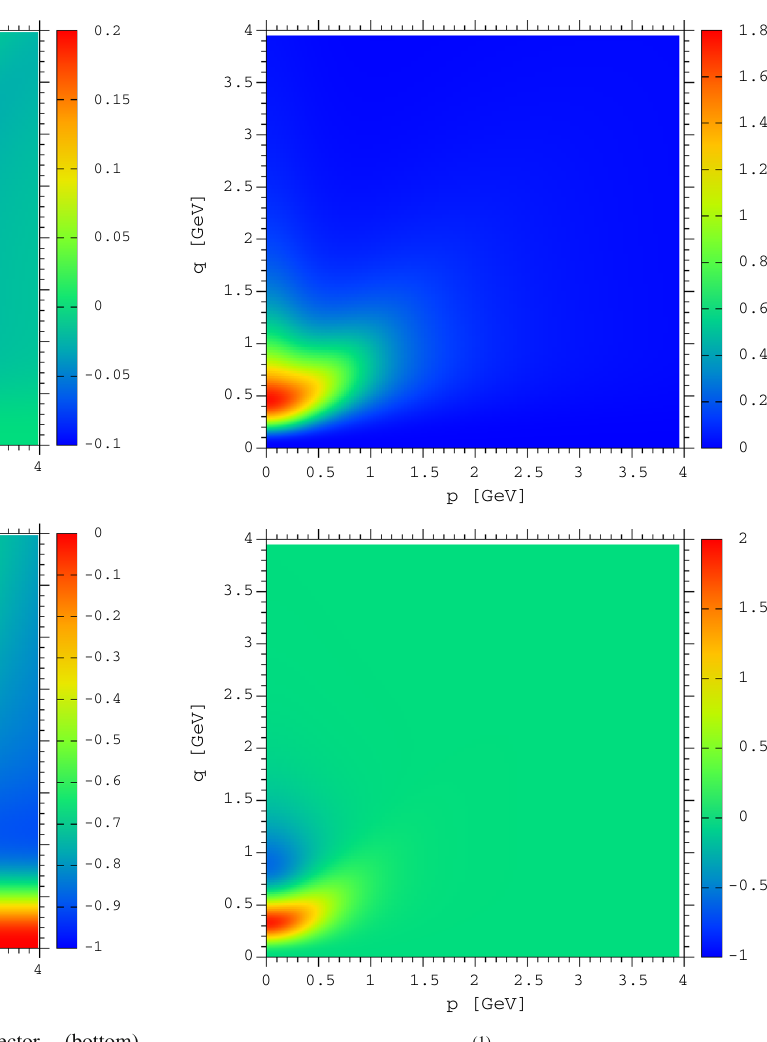
Fig. 9 The scalar (top) N ( 1 ) ( p , q )/ p 2 kernels including the term of the gluon propaga- N ( 1 ) A tor as defined in (60). See also the caption of Fig. 6